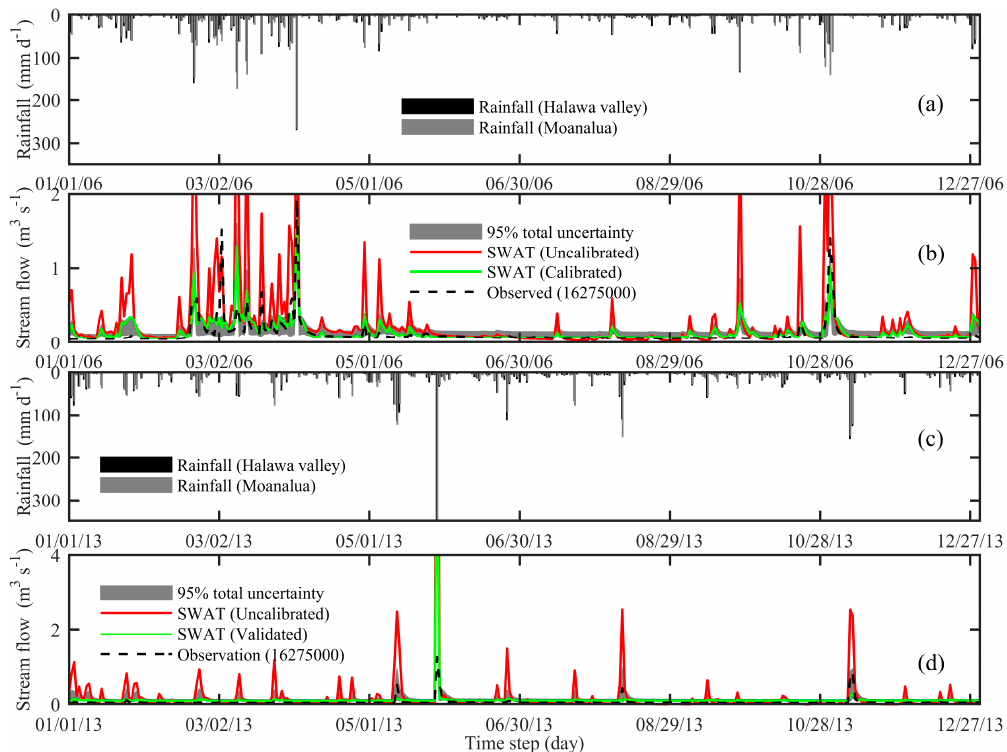
Figure 3. ( a ) Daily gauge rainfall of 2006 and ( b ) the respective observed and simulated daily streamflows at USGS gauging #16275000 (calibration period); and ( c ) daily gauge rainfall of 2013 and ( d ) the respective simulated and observed daily streamflows (validation period) at Haiku.